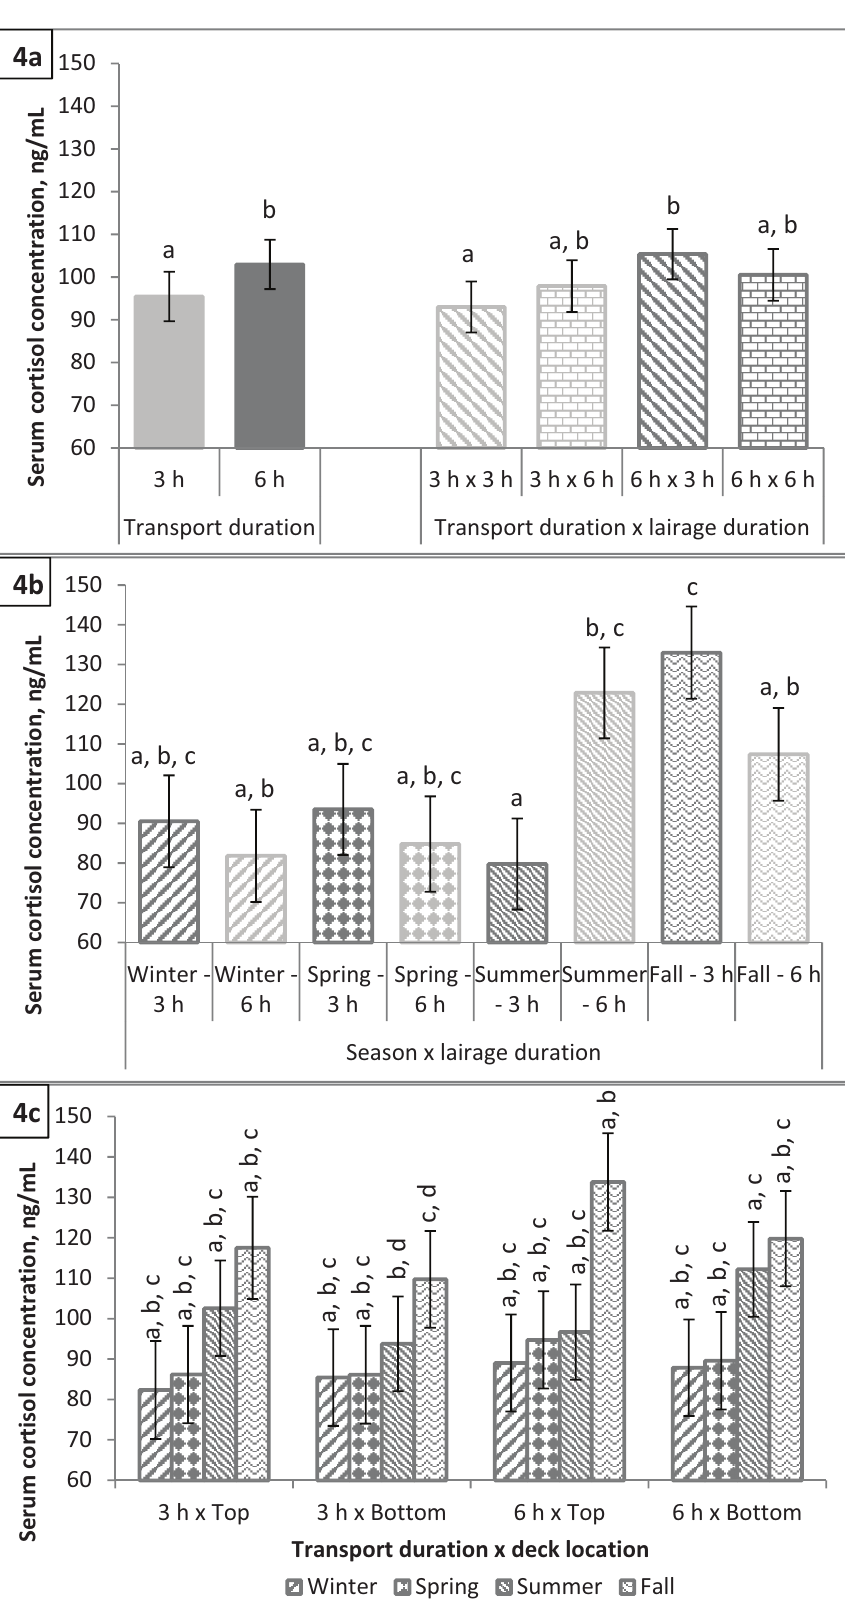
Figure 4. Serum cortisol concentrations ( a ) by transport duration (P = 0.0005) and by transport duration × lairage duration (P = 0.02); ( b ) by season × lairage duration (P < 0.0001); and ( c ) by season × transport duration × deck location (P = 0.02). Values with differing letters differ by P <